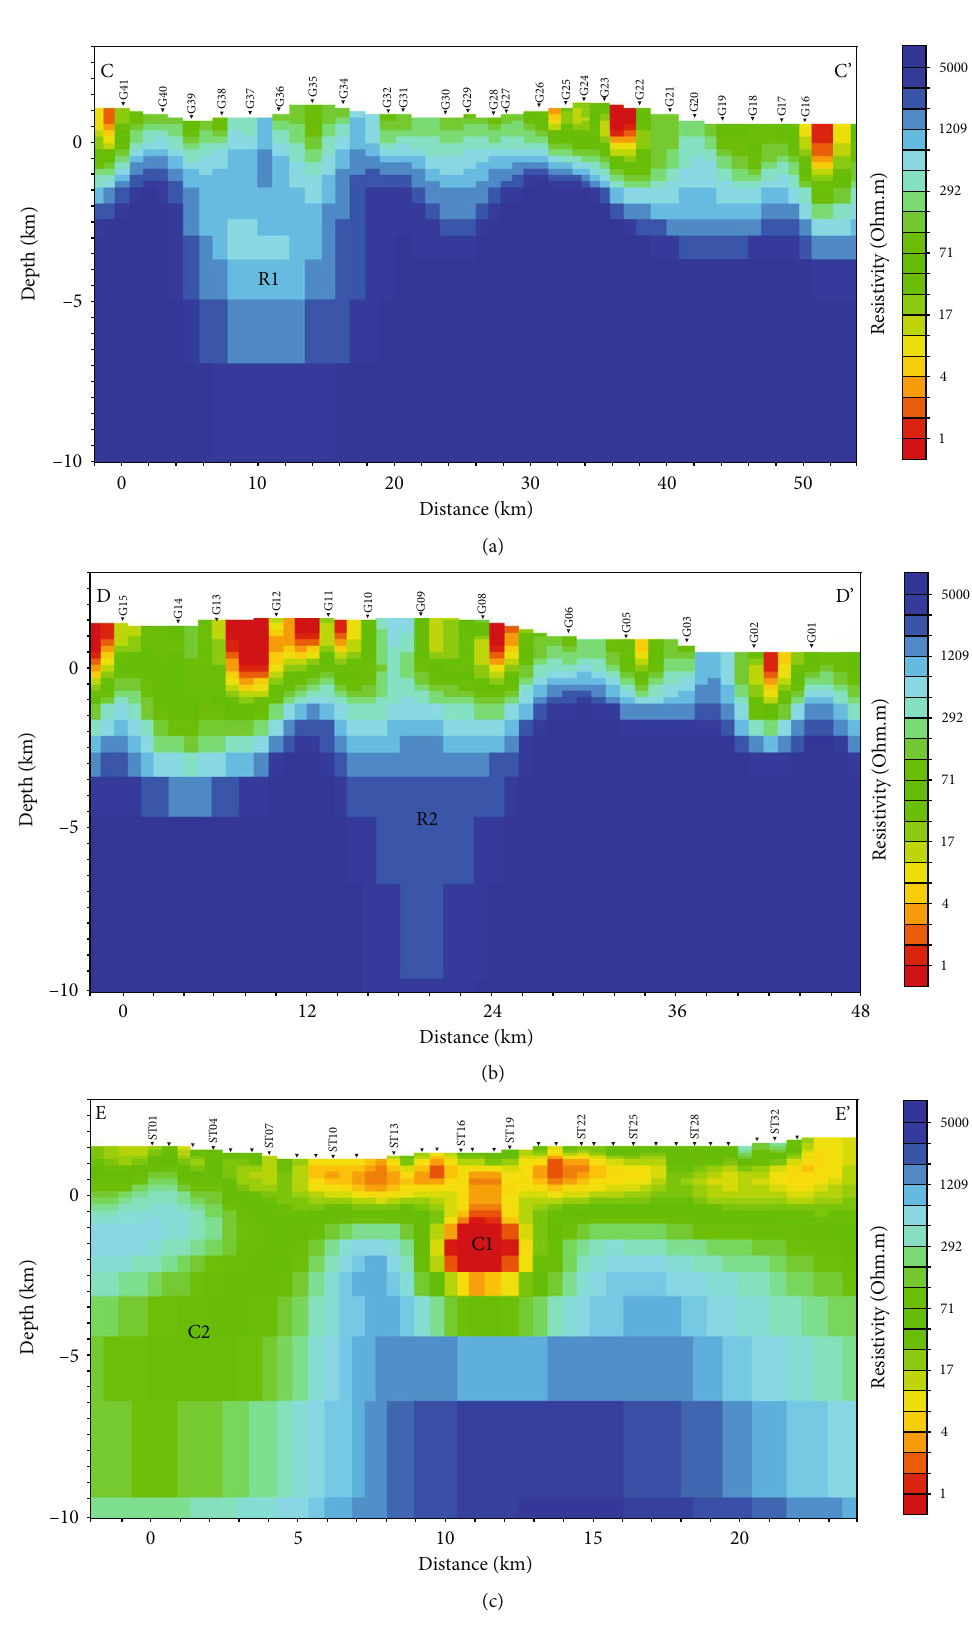
Figure 12: Resistivity model from 2D MT inversion of line C-C ′ (a), D-D ′ (b), and E-E ′ (c). R1, R2, C1, and C2 are resistive and conductive bodies tested in the sensitivity test (see text for